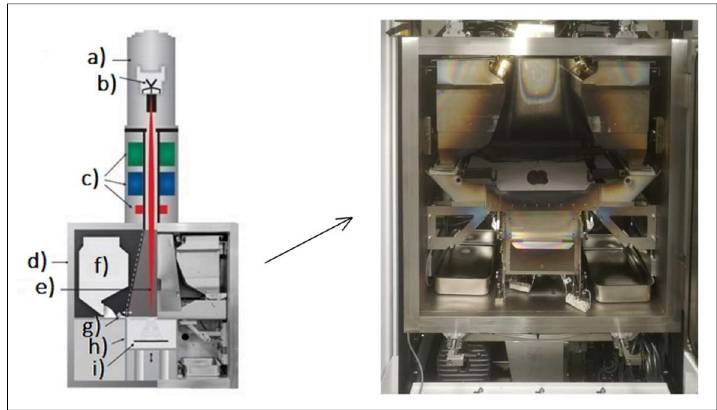
Figure 1. Electron beam powder bed fusion (EB–PBF) machine [29]: (a) Beam generation column; (b) Filament; (c) Lens system; (d) Vacuum chamber; (e) Electron beam; (f) Powder hopper; (g) Rake; (h) Build tank; (i) Start plate.